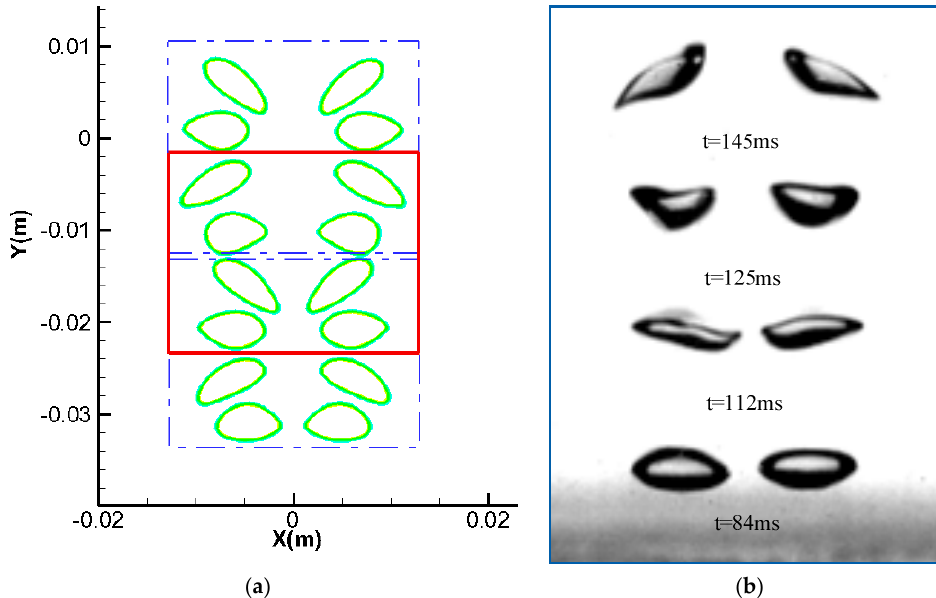
Figure 13. The cyclicity of position relations between two rising bubbles: ( a ) Result obtained by simulation; ( b ) Result obtained by experiment.